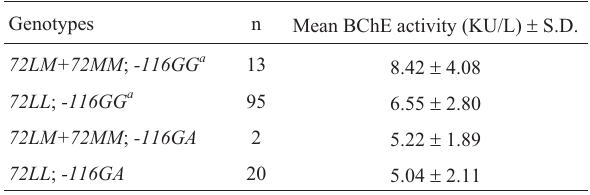
Table 2 - Butyrylcholinesterase mean activity in 130 obese individuals, grouped by genotypes of GHRL ( Leu72Met ) and BCHE ( G-116A ) genes.